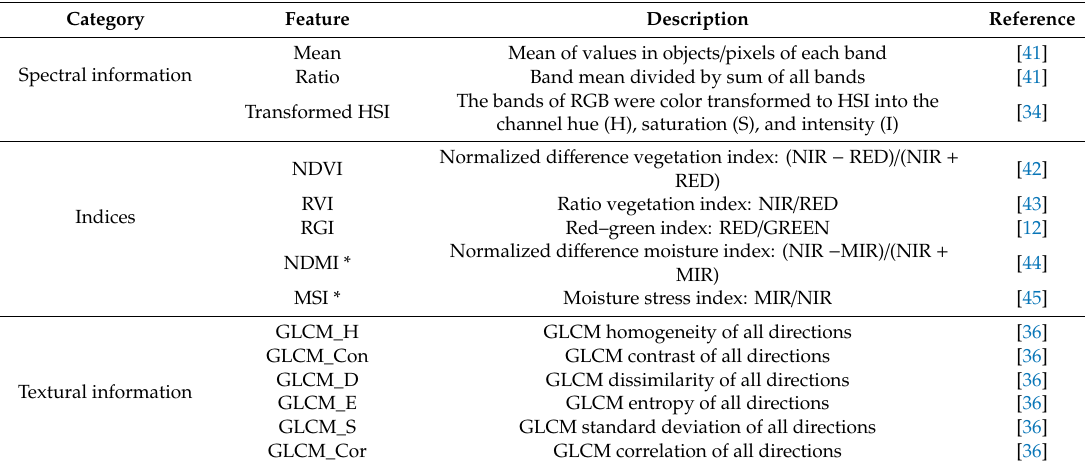
Table 3. All features extracted from GF2 and S2